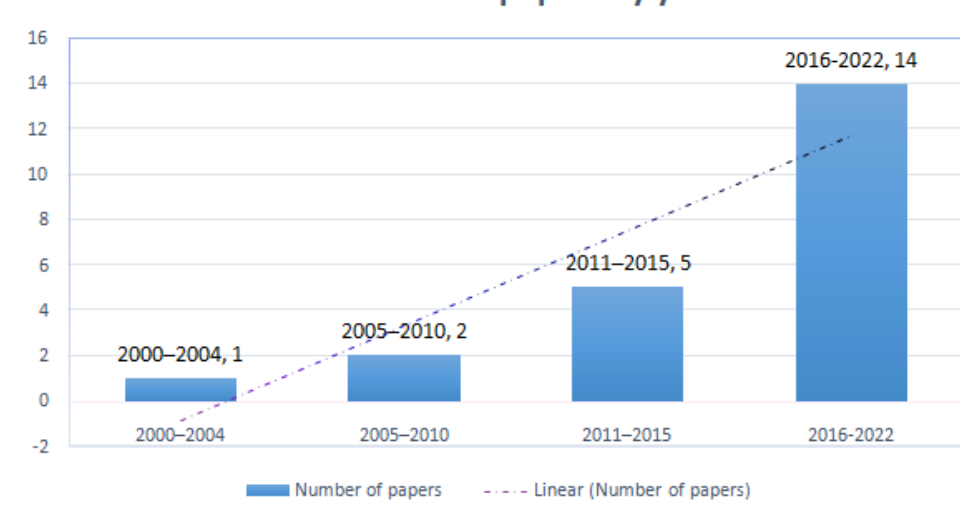
Figure 4. Distribution of the selected papers by year (author’s work) .